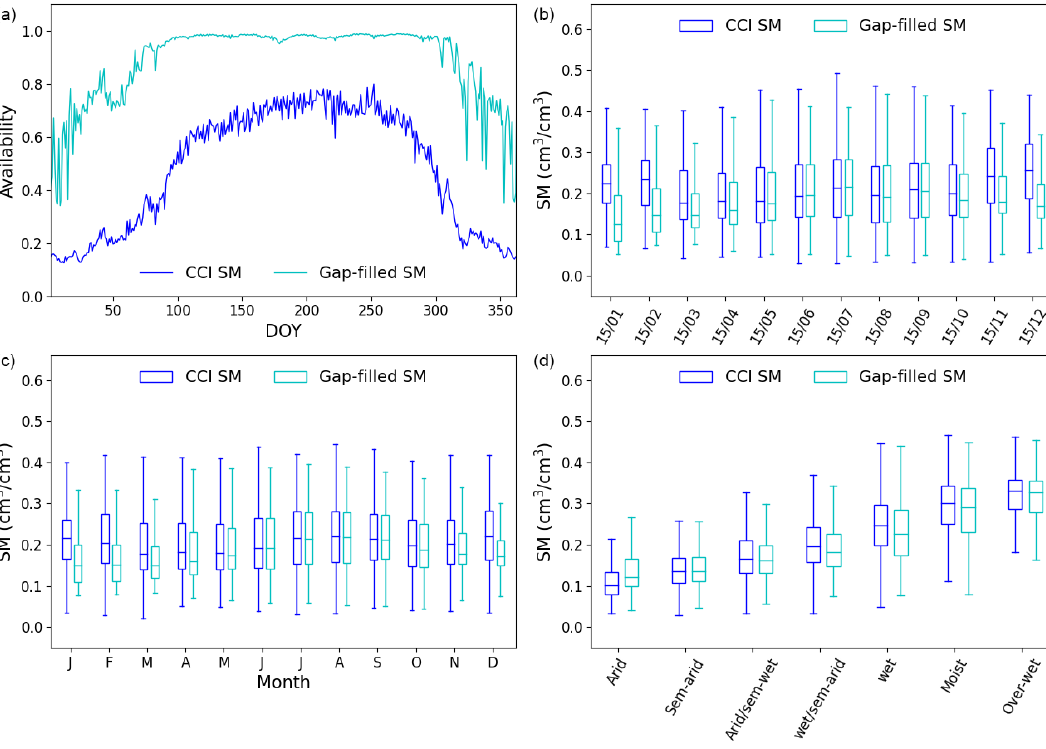
Figure 5. Comparison between the CCI dataset and gap-filled SM in 2009. (a) Plots of the availability of the CCI dataset and gap-filled SM. (b) Box plot of the CCI dataset and gap-filled SM on the selected days. (c) Box plot of the month-average CCI and gap-filled SM. (d) Box plot of raw and gap-filled SM regarding seven climate regions.